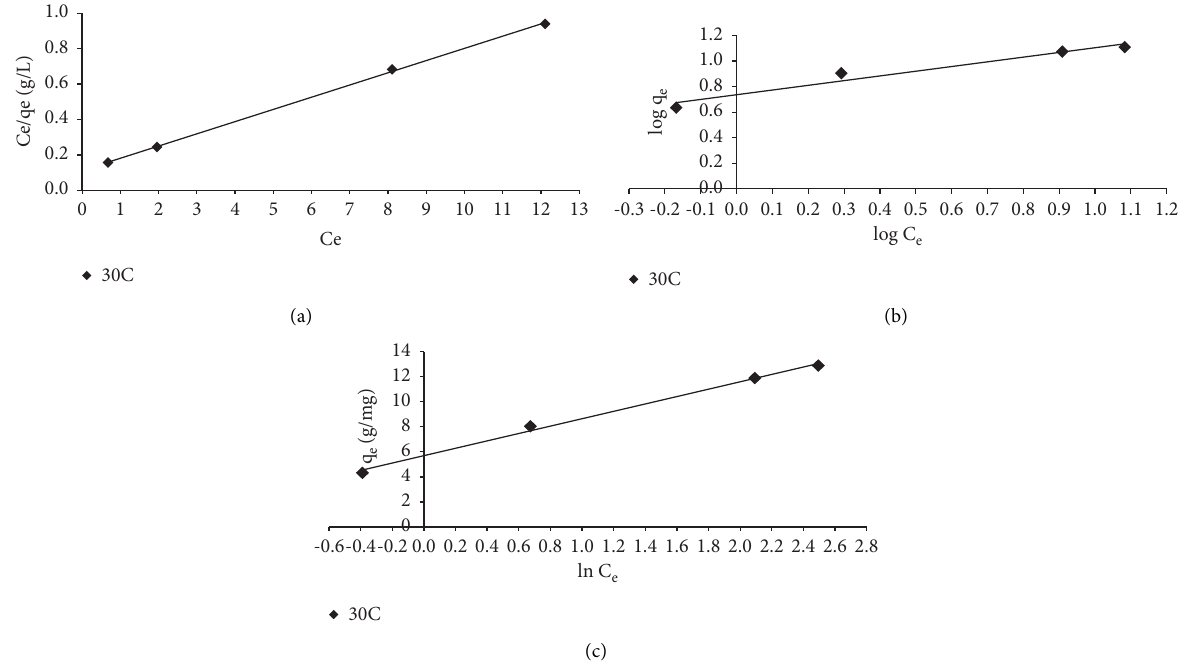
Figure 11: Linearized plots of (a) Langmuir, (b) Freundlich, and (c) Temkin models for DDTadsorption onto CSAC (solution temperature of 30 ° C, adsorbent dose of 0.2g solution volume of 200 mL, and solution pH of 7).